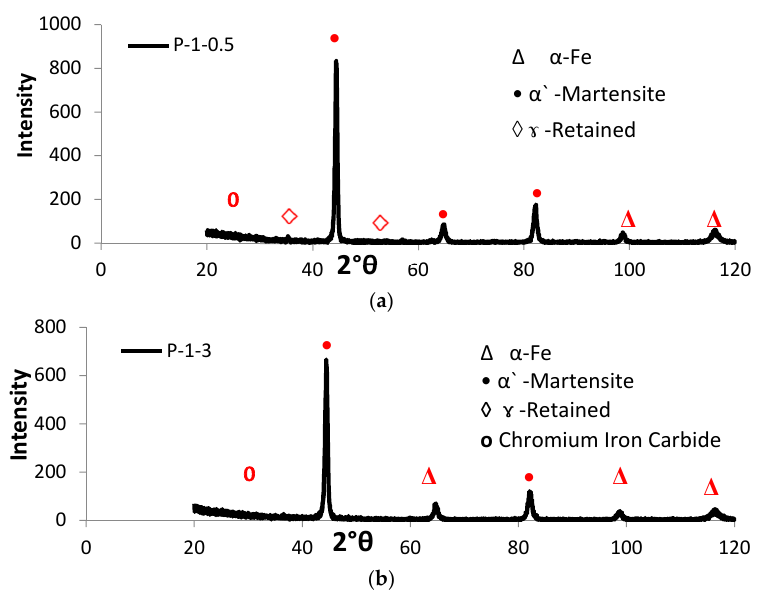
Figure 7. XRD spectra for various LHT AISI 416 specimens processed at laser power 1000 W and scanning speeds of ( a ) 0.5 and ( b ) 3 m ∙ min − 1 .